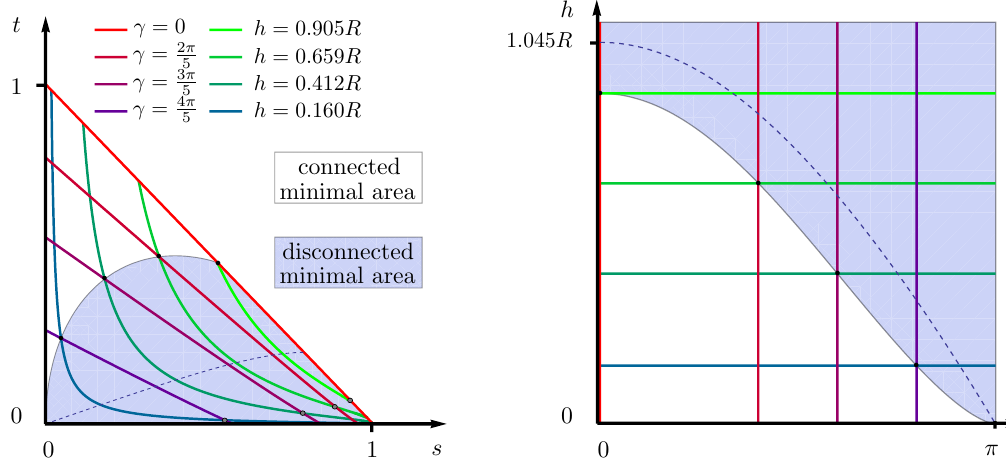
Figure 2 . Connected and disconnected world-sheet phases in the real string domain. The dashed line represents another critical behavior. Below it no stable connected solution